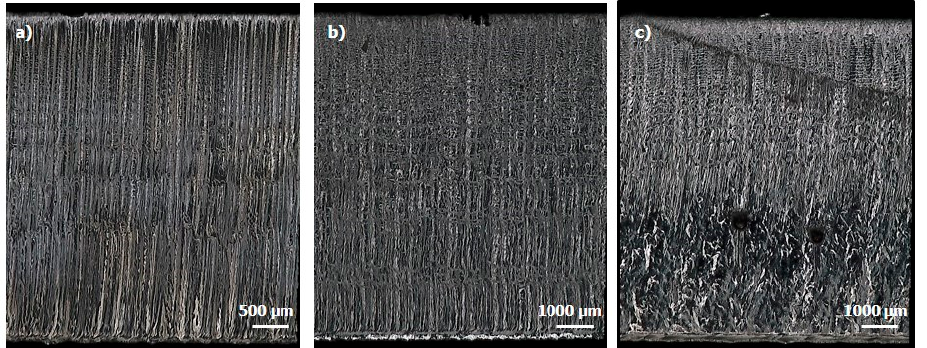
Figure 22. St37-2 kerf lateral surface: ( a ) 5 mm, Cs = 100% P = 100%; ( b ) 5 mm, Cs = 50% P = 100%; ( c ) 2.5 mm, Cs = 50% P = 100%.